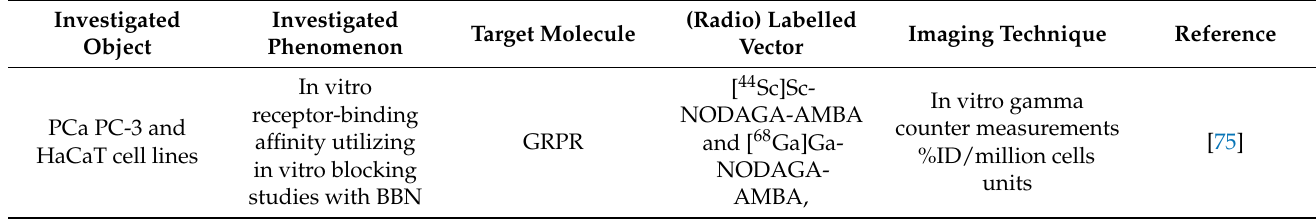
Table 1. Preclinical studies with 44 Sc-labelled PET